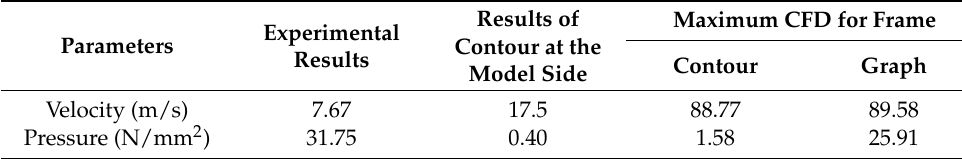
Table 14. Comparison between dam-break and CFD results for IBS